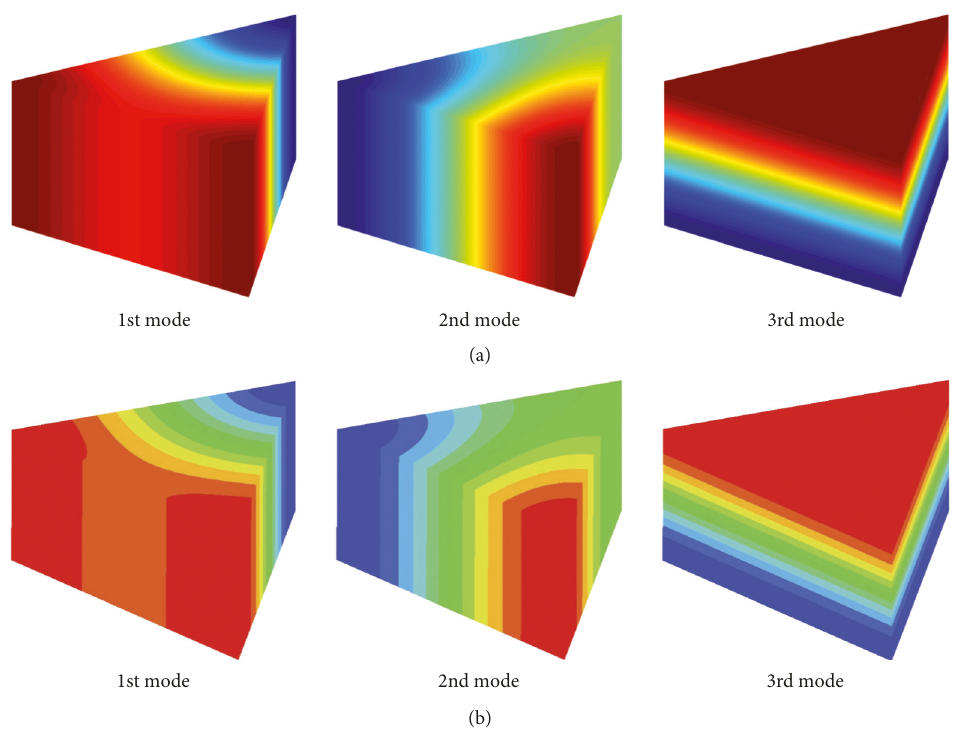
Figure 3: The first three modals of acoustic pressure distribution of the triangular prism acoustic cavity. (a) Present. (b) FEM. Table 4: The first eight natural frequencies (Hz) of quadrangular prism acoustic cavities with different shapes. Model sequence Mediums Shapes